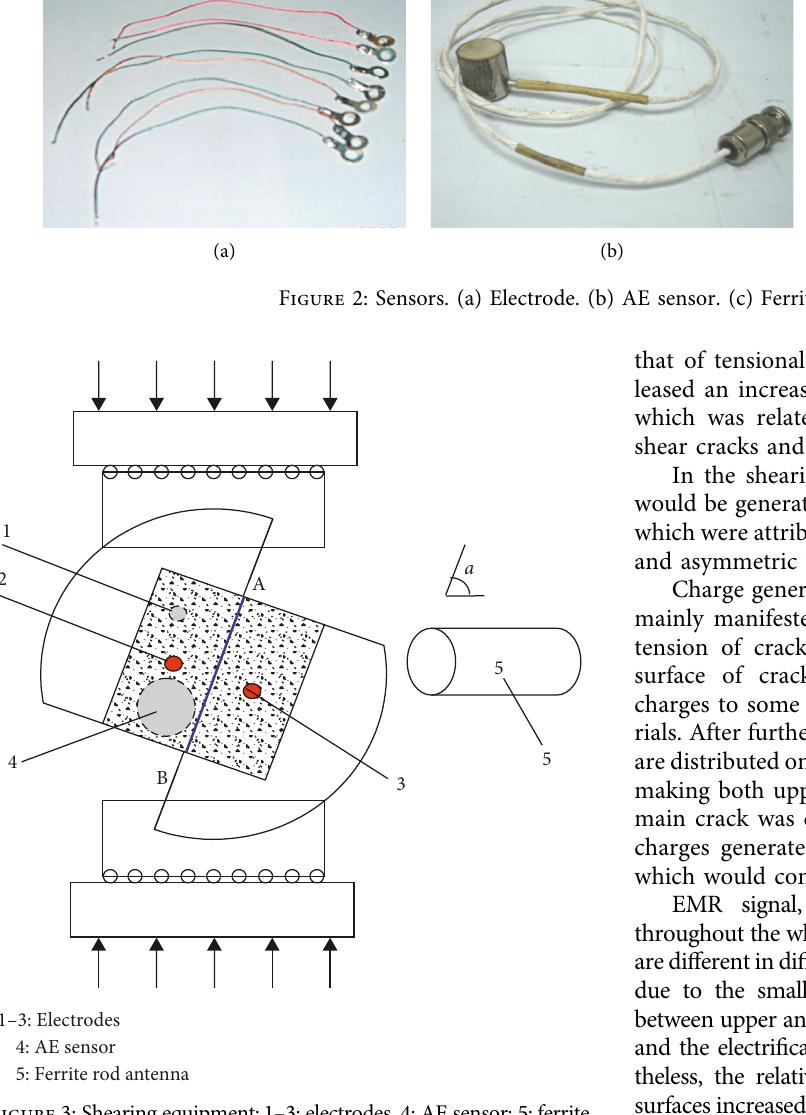
Figure 3: Shearing equipment:1–3: electrodes, 4: AE sensor; 5: ferrite rod